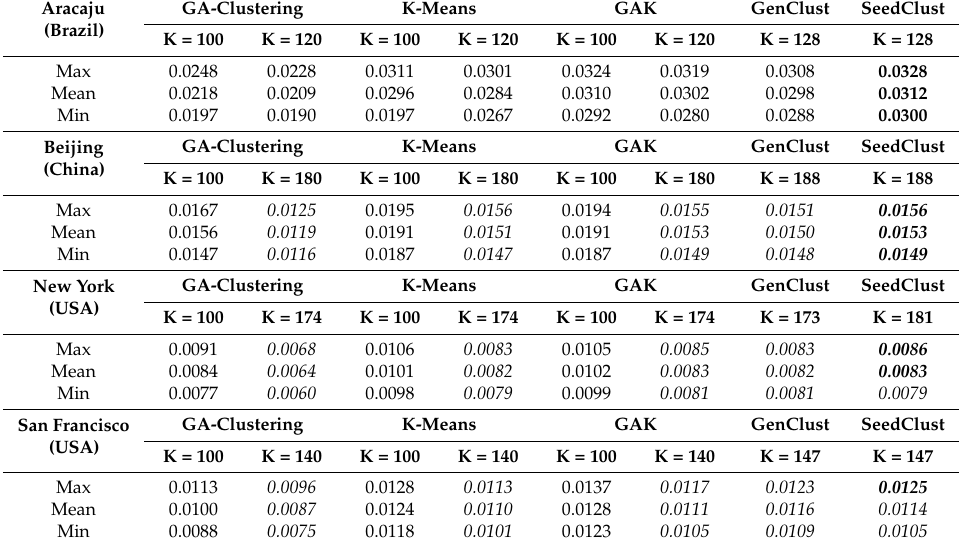
The bold font indicates the best value for each taxi GPS data set. Table 5. The maximum, mean, and minimum values of PBM obtained by GA-clustering, GAK, K-means, and SeedClust algorithms for 20 different runs for four real-world taxi GPS data